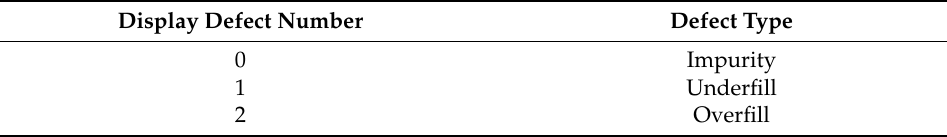
Table 3. Display defect number–type mapping.